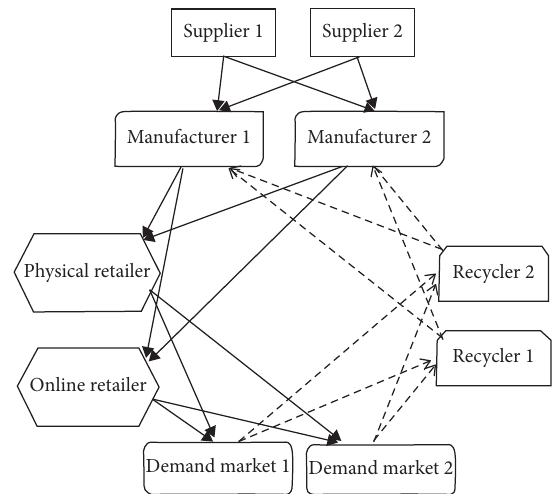
Figure 1: Network structure of the low-carbon supply